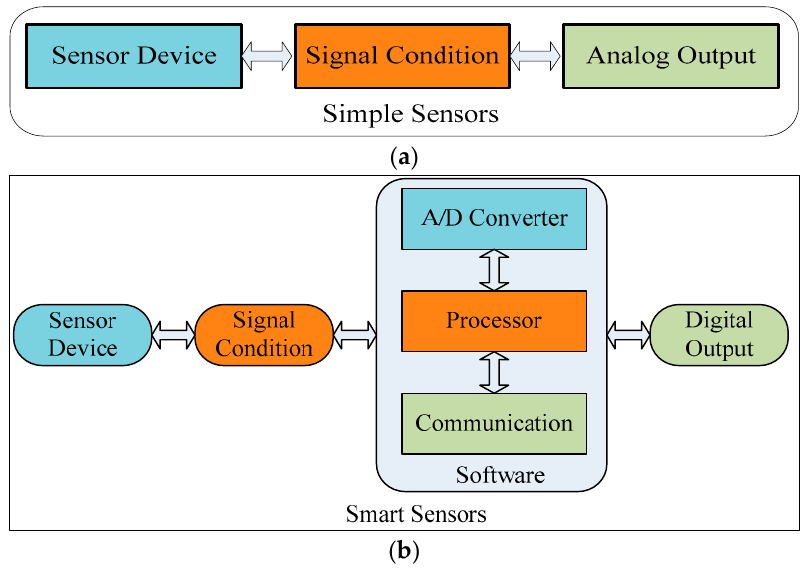
Figure 7. Block diagram of the simple sensors ( a ) and smart sensors ( b ).